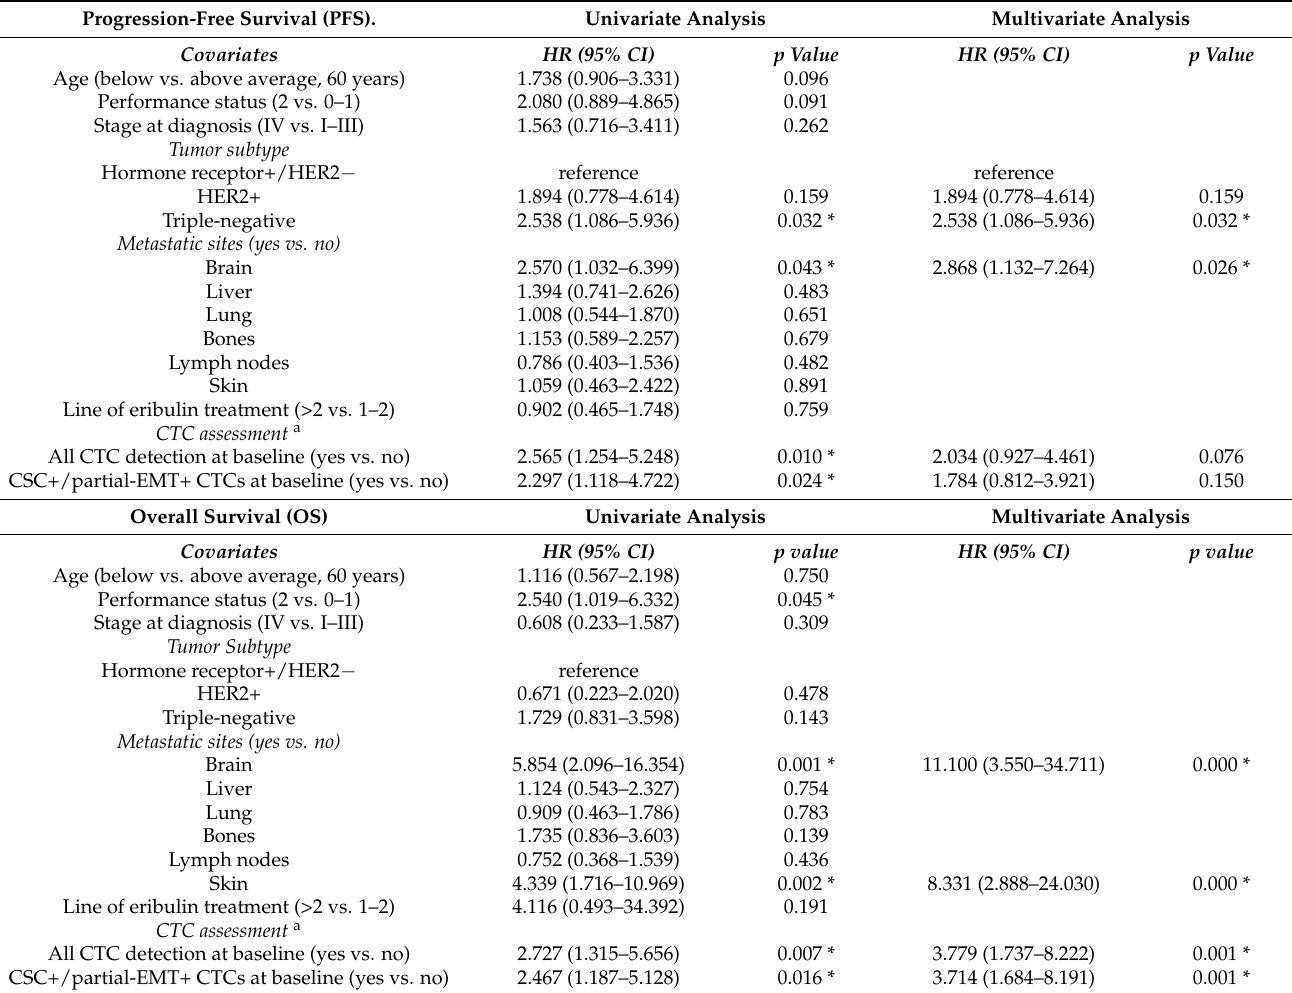
Table 3. Cox regression analysis for PFS and OS prediction in the entire population of patients with metastatic BC ( n =